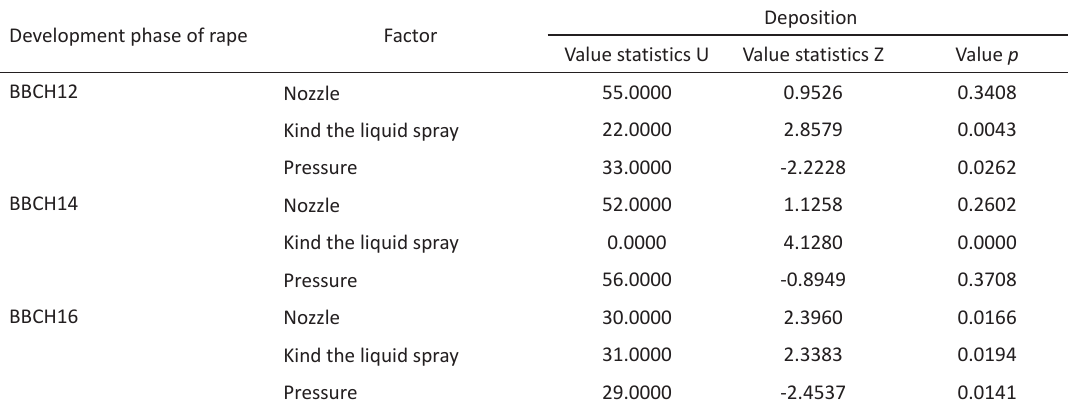
Table 2. The results of Mann-Whitney U test for the studied development phases of winter oilseed rape Development phase of